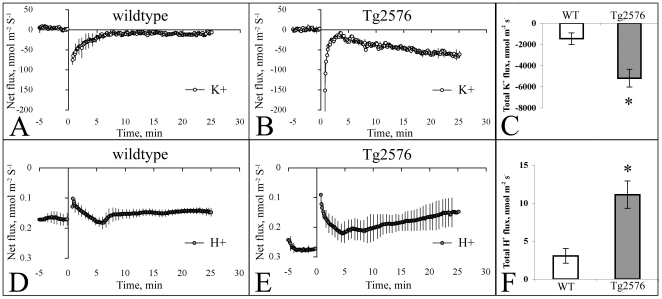
Soluble Aβ induces rapid efflux of K+ in Tg2576 cortical neurons.Treatment with 1 µM Aβ1-40 triggered rapid efflux of K+ from wildtype neurons (A), which returned to homeostasis within 10 minutes. However, Tg2576 neurons treated with Aβ1-40 displayed a continual efflux of K+ over the recording period (B). Measurement of total K+ flux over 25 minutes following Aβ1-40 treatment revealed that significantly more potassium was extruded from Tg2576 neurons than wildtype neurons (C). Aβ1-40 treatment caused a rapid influx of H+ in both wildtype (D) and Tg2576 (E) neurons, which stabilised within 5 minutes. However, from about 10 minutes post-treatment, Tg2576 neurons underwent a slow gradual influx of H+ (E). Measurement of total H+ flux over 25 minutes revealed that Aβ1-40 induced significantly greater influx of H+ into Tg2576 neurons in comparison to wildtype neurons (F). * - p<0.05, t-test. Error bars represent standard error values.